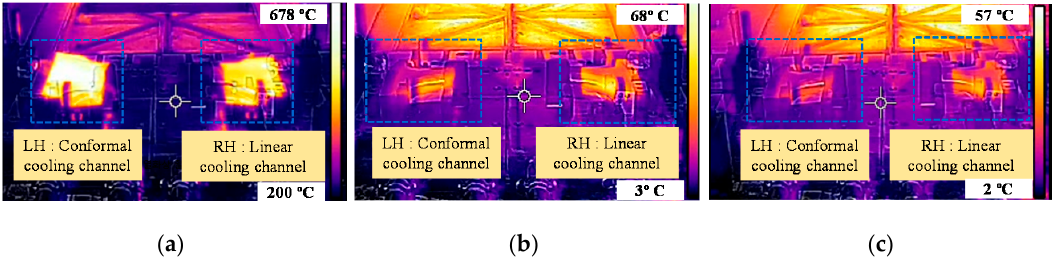
Figure 18. Results of measurement by thermal imaging camera before and after forming: ( a ) heated blank placed on die, ( b ) the temperature comparison immediately after the rise of the die, and ( c ) the temperature comparison 5 s after the rise of the die.